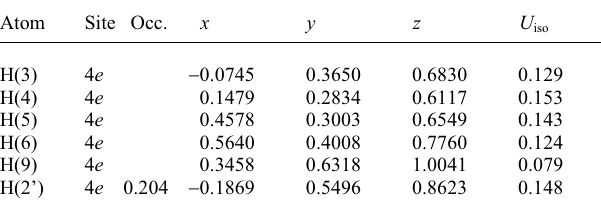
Table 3. Atomic coordinates and displacement parameters (in Å 2 )